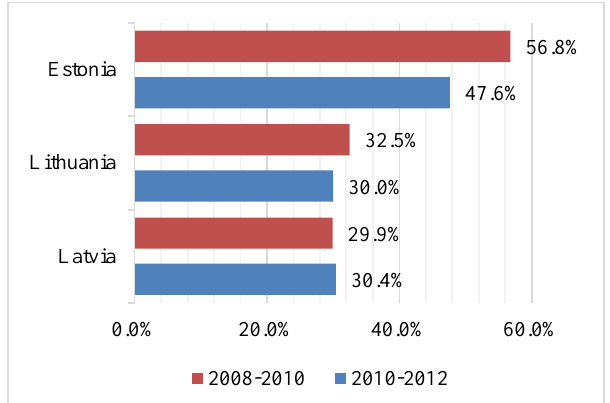
Fig. 2. Innovative activity of Latvia, Lithuania and Estonia (the author’s chart based on CSP, 2014). According to statistical data, in comparison with the Baltic countries, Latvia had the lowest innovative activity (see Fig. 2).